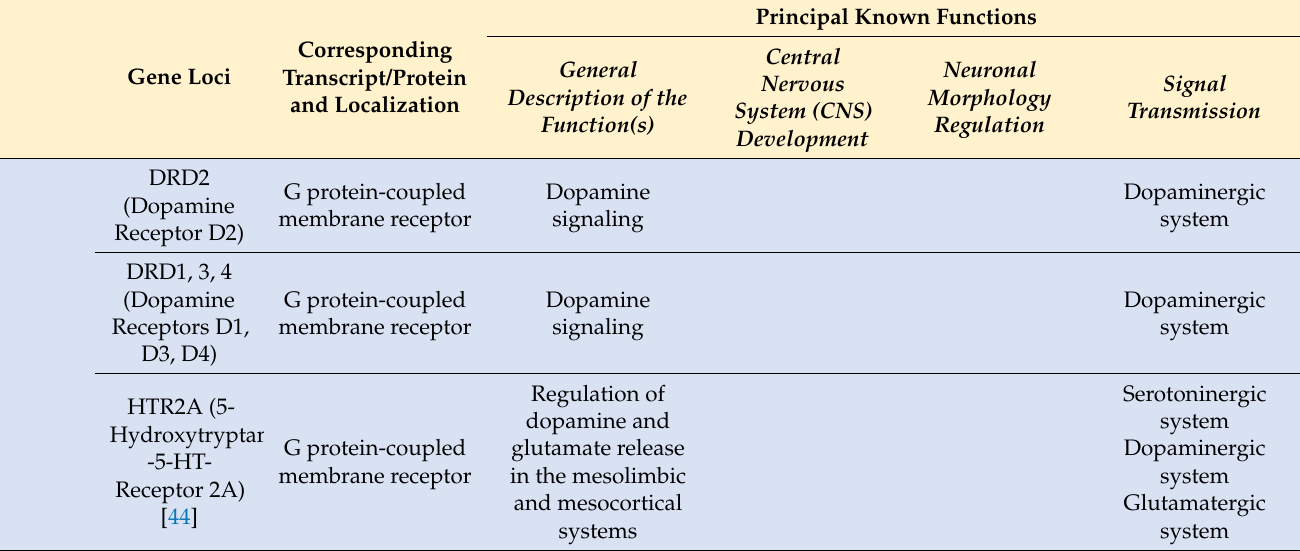
Table 1. Gene loci associated with a higher risk of developing primary